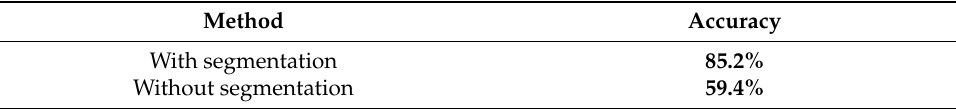
Table 3. Evaluating the effect of ROI regions segmentation on